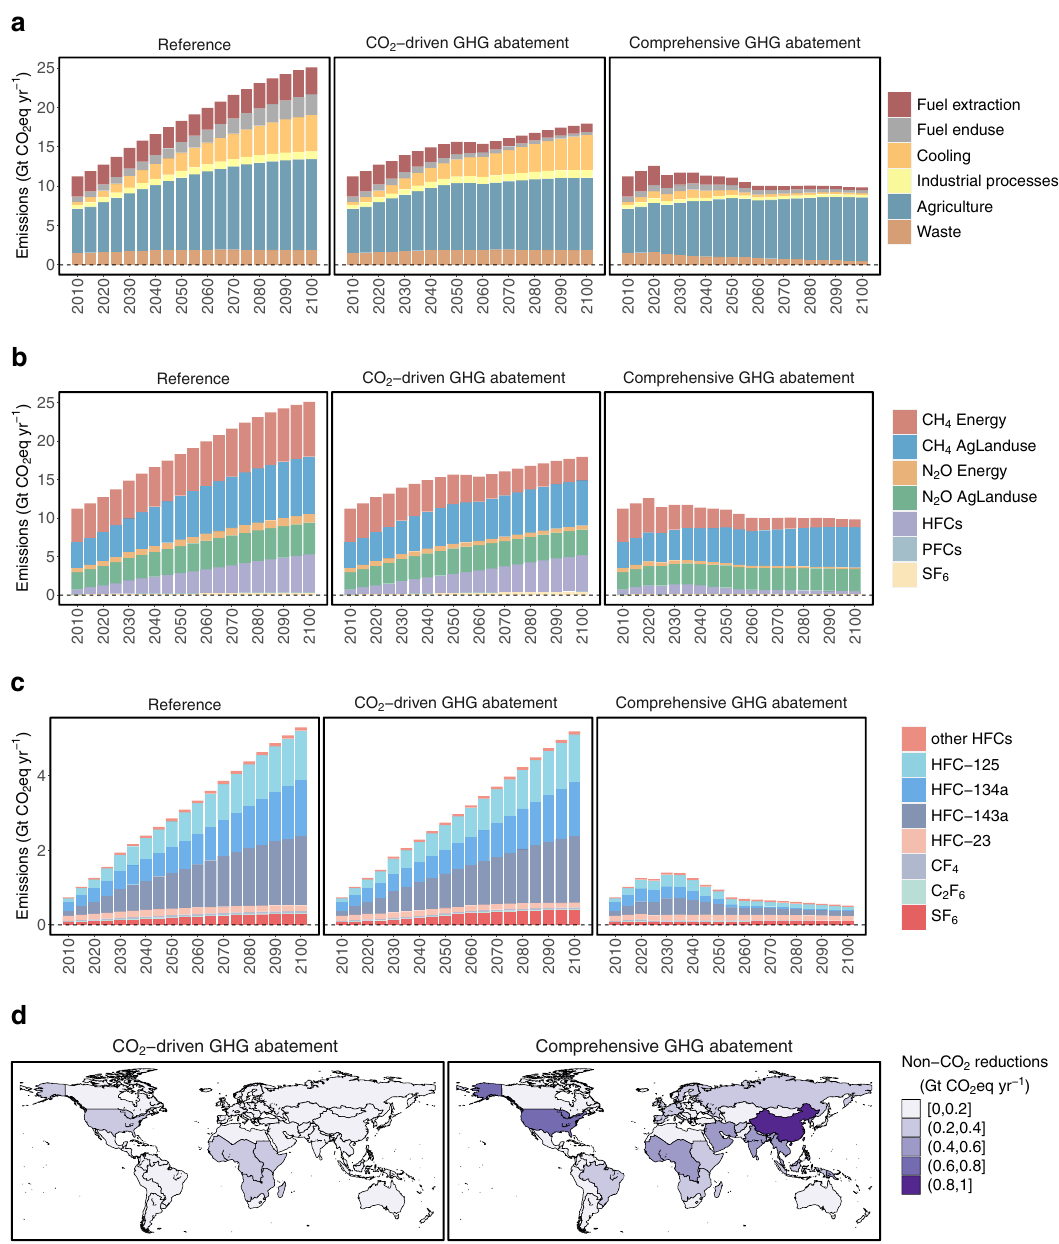
Fig. 3 Global non-CO 2 GHG emissions. Emissions by ( a ) sector and ( b ) species, ( c ) F-gas emissions by species, and ( d ) reductions in 2050, when reaching net-zero CO 2 emissions by 2053 (and − 8 GtCO 2 in 2060) for a 1.5 °C scenario. Other HFCs include HFC-32, HFC-43, HFC-152a, HFC-227ea, HFC-236fa, HFC-245fa, and HFC-365mfc. Non-CO 2 GHG emissions were aggregated with GWP-100, from ref. 28 . Global maps in this fi gure are created using an open-source R package. 55 and documented in ref. 56